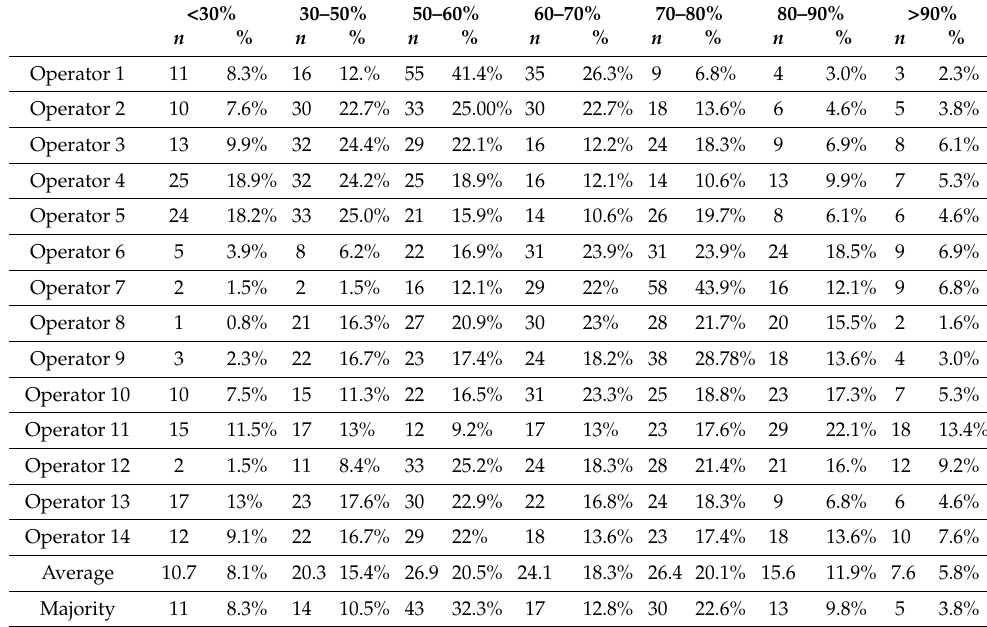
Table A1. Stenosis severity as graded by each operator and based on decision of majority.